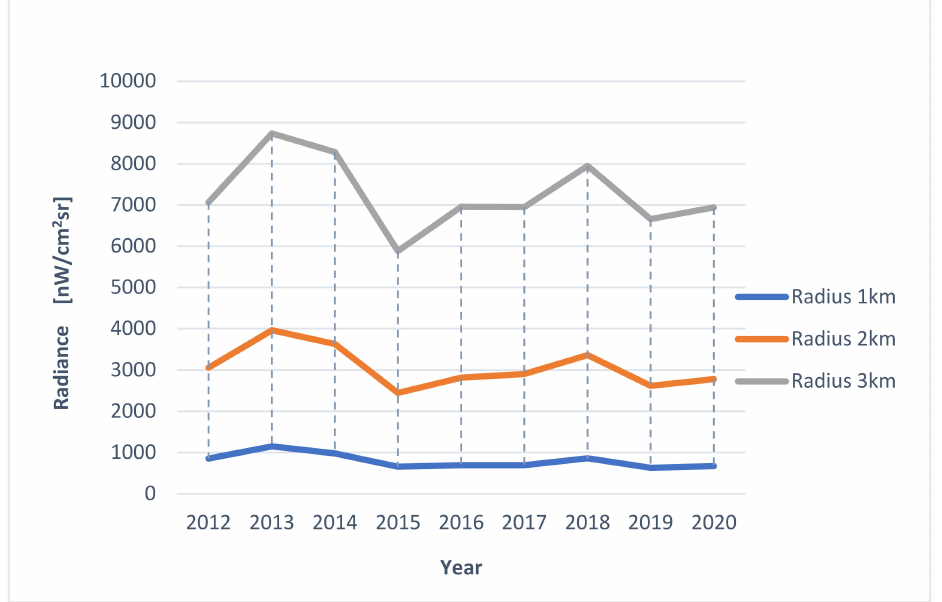
Figure 14. Light pollution changes from 2012 to 2020 based on a 1 km, 2 km, and 3 km radius. Source: authors’ elaboration based on data from https://www.lightpollutionmap.info/ (accessed on 5 May